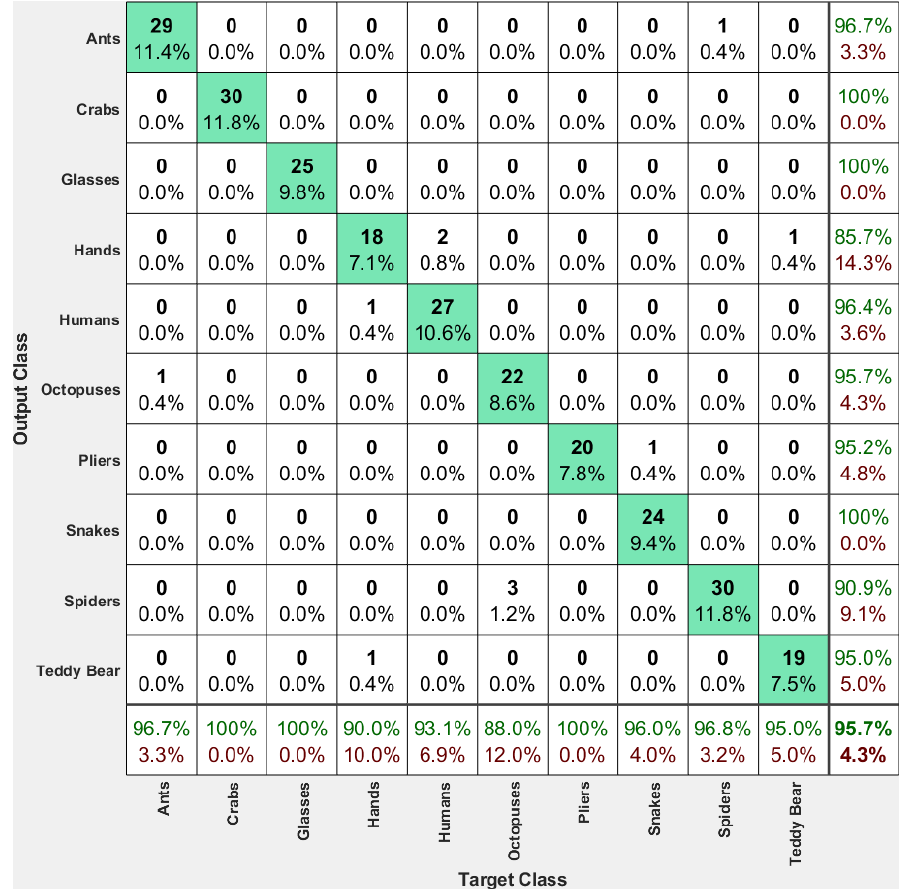
Figure 6. Confusion matrix obtained from linear multi-class SVM for McGill dataset using LESI